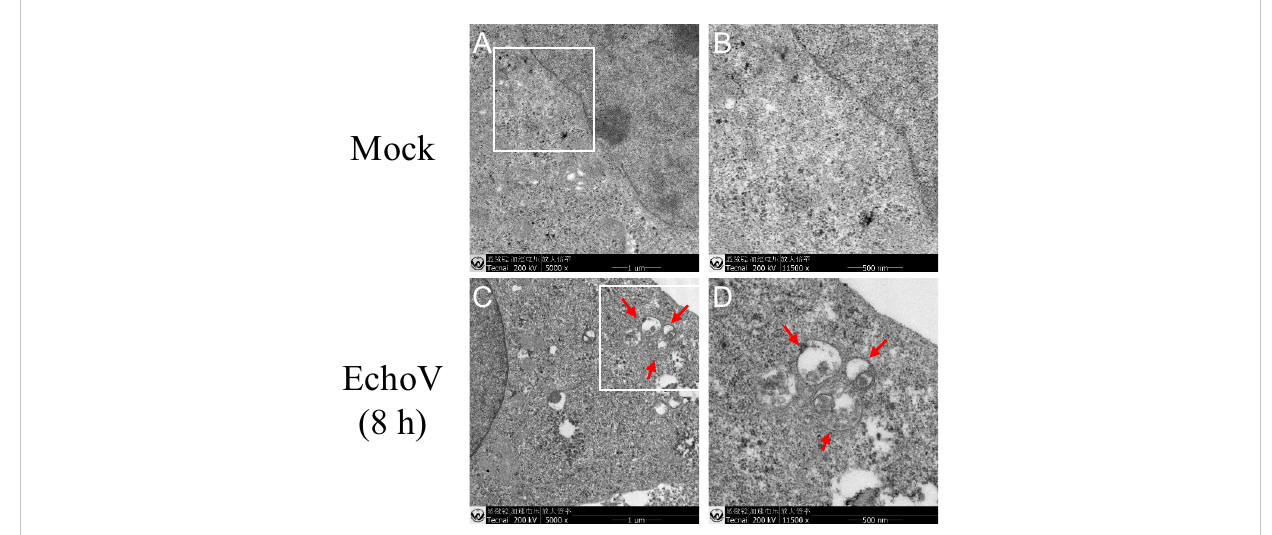
FIGURE 4 Echovirus infection induces autophagosome formation. RD cells were infected or not (Mock) with echovirus 11 at 1 MOI for 1.5 h. At 8 h post- infection, cells were then fi xed and subjected to transmission electron microscopy analysis. Lower magni fi cation of Mock (A) and EchoV-infected (C) cells. (B) Higher magni fi cation of the area in white square of (A) ; (D) Higher magni fi cation of the area in white square of (C) . Scale bar in A and C, 1 µm; Scale bar in B and D, 500 nm. The autophagosomes are denoted by red